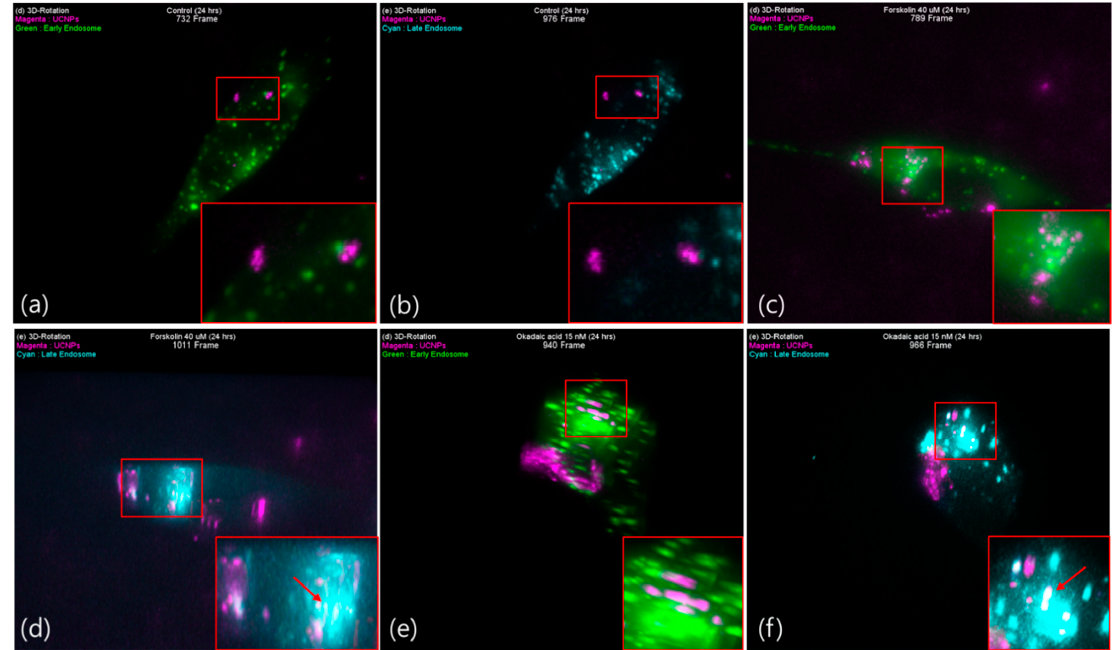
Figure 6. Late state colocalization of UCNPs with early endosomes or late endosomes in tau aggregated SH-SY5Y cell. ( a ) Control 24 h (732 frame), ( b ) Control 24 h (976 frame), ( c ) forskolin 24 h (789 frame), ( d ) forskolin 24 h (1011 frame), ( e ) okadaic acid 24 h (940 frame), and ( f ) okadaic acid 24 h (966 frame). Magenta: UCNPs, green: early endosome, cyan: late endosome. In case of cells treated with forskolin (40 µM) and okadaic acid (15 nM), majority of UCNPs remained inside the cells co-localized with late endosome and Lysosome (Figure